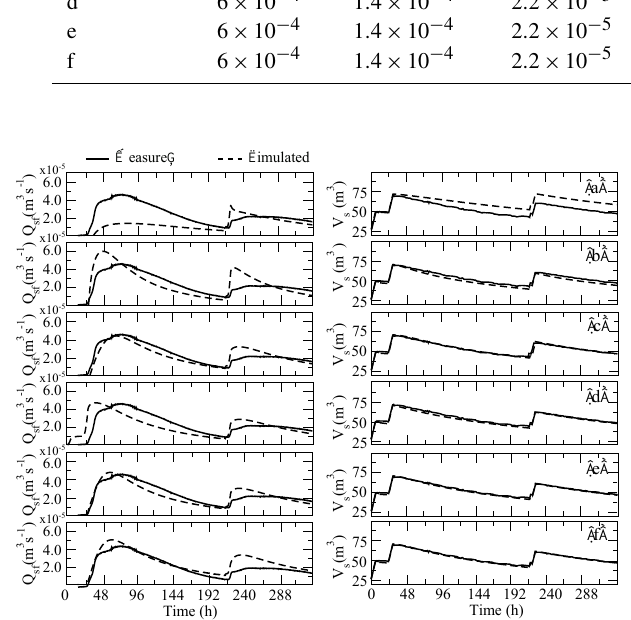
Figure 4. Results for the six simulations of the integrated flow re- sponse analysis (see Table 2). For each case the seepage face flow Q sf (left) and total water storage V s (right) are